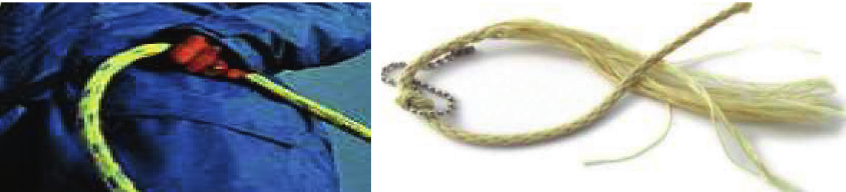
Figure 6: Vectran cable and rope